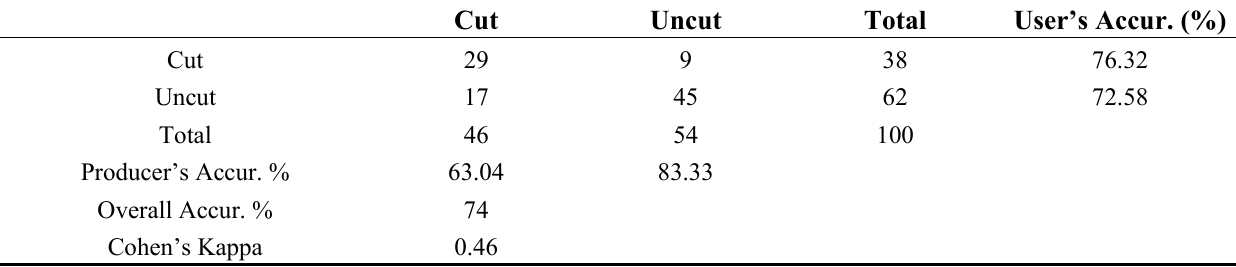
Table 4. Confusion matrix and accuracies of raw EVI data set (14 April to 21